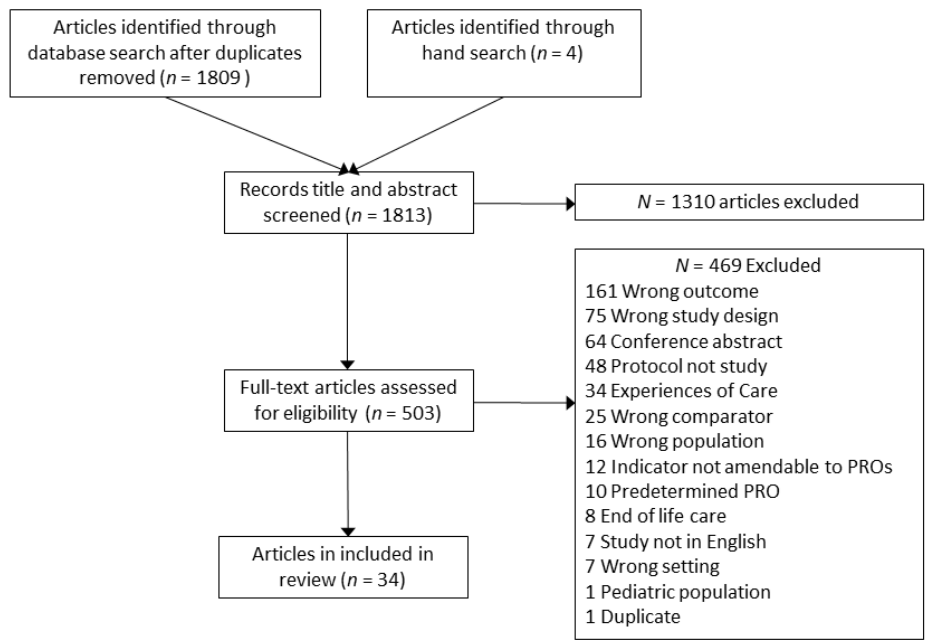
Figure 1. PRISMA diagram for article inclusion.